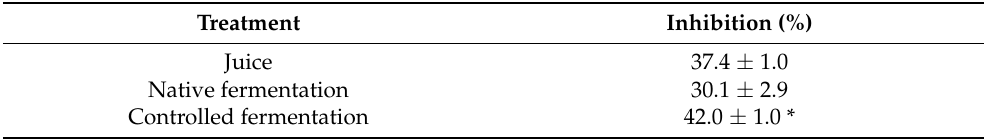
Table 5. In vitro α -glucosidase inhibitory effect (%) of the juice of C. ficifolia and samples at 48 h of native and controlled fermentation.